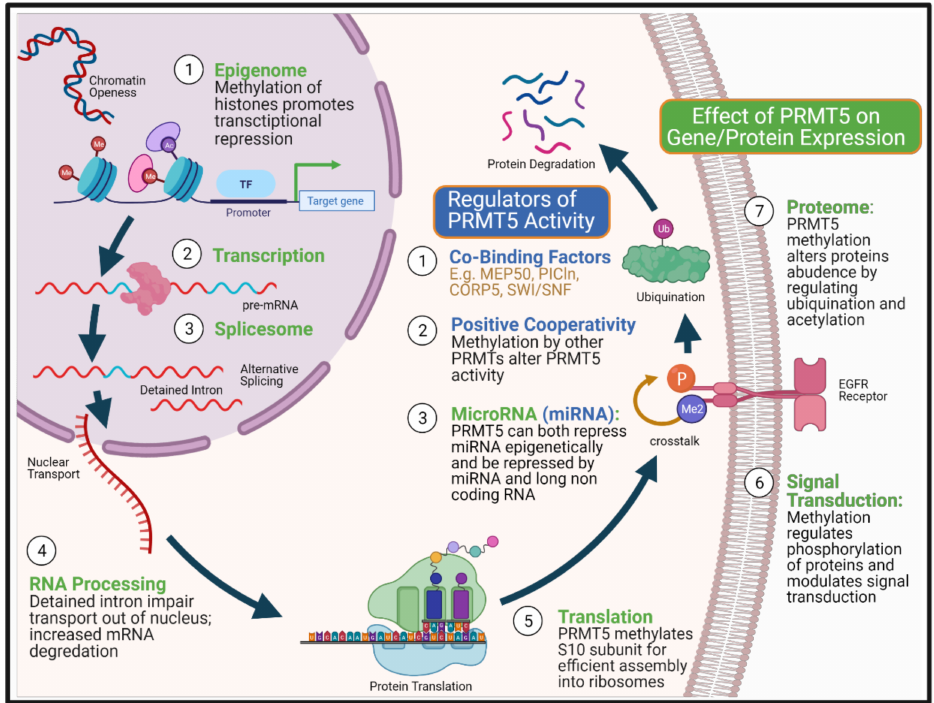
Figure 1. Multi-level control of gene and protein expression by PRMT5. The figure summarizes biological points at which PRMT5 can impact on both gene and protein expression (green colour), from epigenetic repression to post-translational modification of the protein, altering both the stability and capacity for signalling. PRMT5 achieves this complex multi-level of control via methylation of arginine residues on histones and non-histone proteins. PRMT5’s enzymatic activity is also mod- ulated by three types of factors (blue colour). First, by PRMT5’s co-binding factors that determine its substrate fidelity as well as the location of action. Part of PRMT5 pathogenicity arises from its suppression of less well characterised non-coding RNA as well as being regulated by these microR- NAs. Its positive cooperativity with other PRMTs may alter the rate and scope of biological response from protein interactions without necessarily causing changes in mRNA transcript expression. The complexity of PRMT5 interactions therefore hinder its development as a therapeutic target. Created with